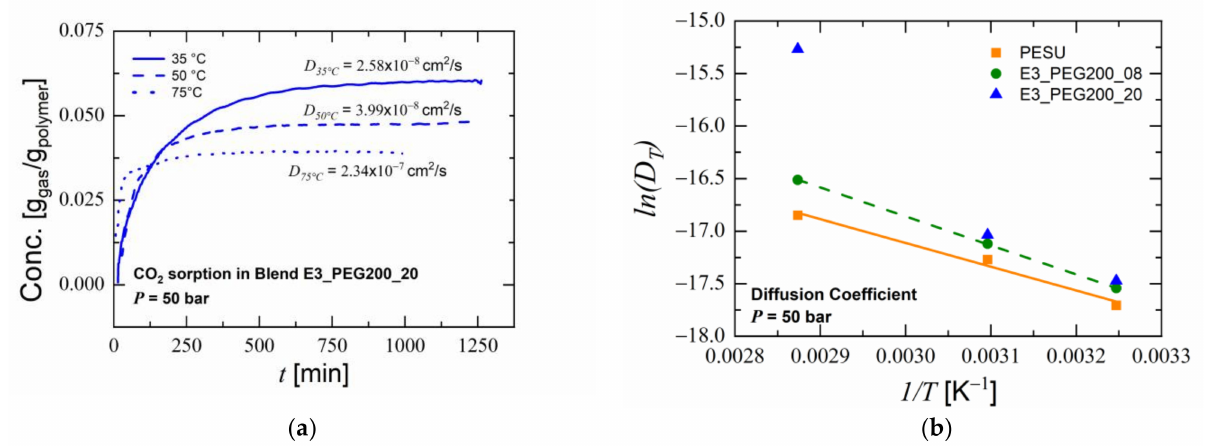
Figure 9. Sorption measurements results: ( a ) concentration of CO 2 in blend E3_PEG200_20 versus time at various temperatures; ( b ) Arrhenius plot of diffusion coefficients of